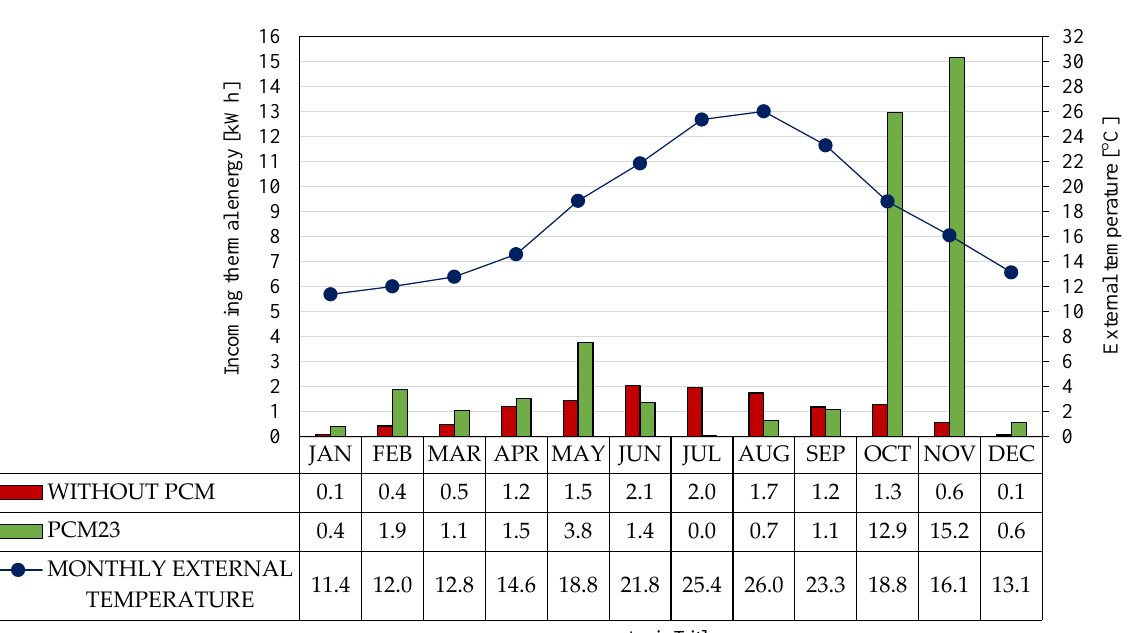
Figure 11. Comparison of the exiting thermal energy through the SuberWall panel between CASE 1 and CASE 2 with PCM23.